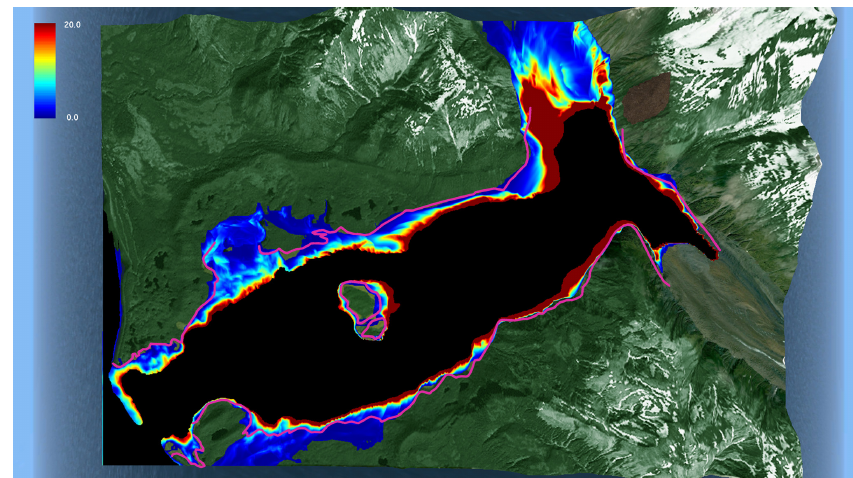
Figure 14. Simulated inundated areas and maximum height all around Lituya Bay. Trimline in